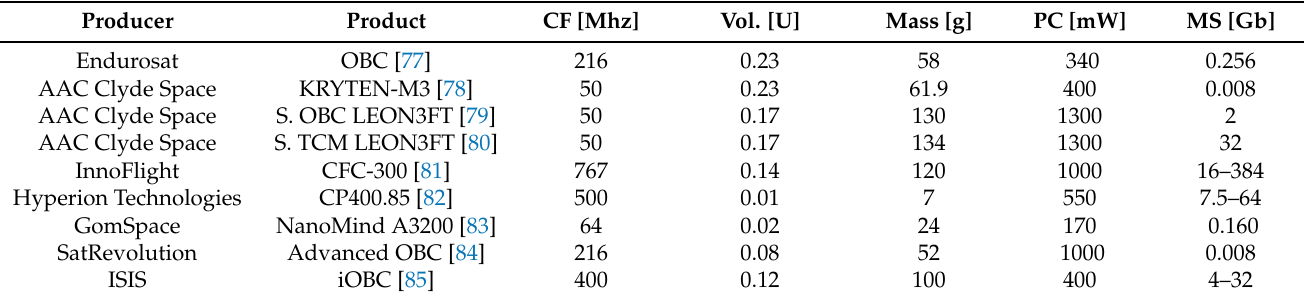
Table 5. Commercial-off-the-shelf (COTS) On-Board Computer (OBC)